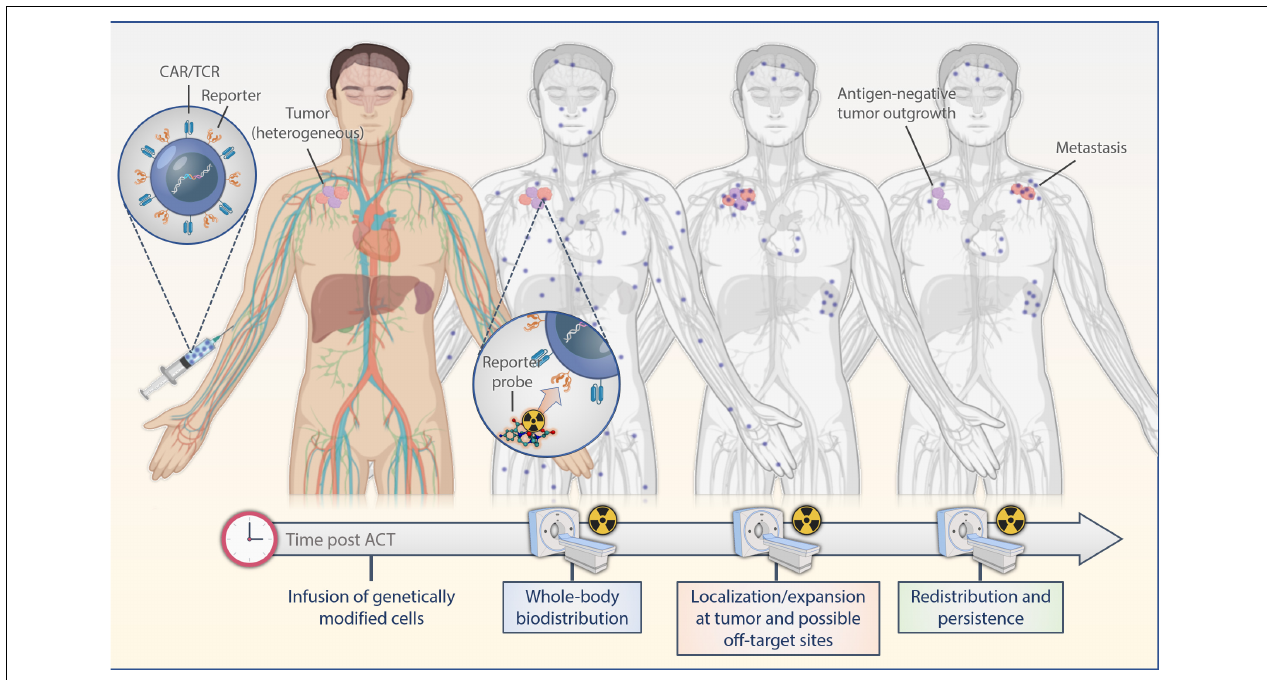
FIGURE 2 | Scheme of reporter-based molecular imaging. If the expression of the reporter gene is stable, labeled cells can be observed over their entire lifetime allowing for extended longitudinal studies upon serial infusions of reporter-specific probes with PET or SPECT in the whole body. ACT, adoptive cell transfer.